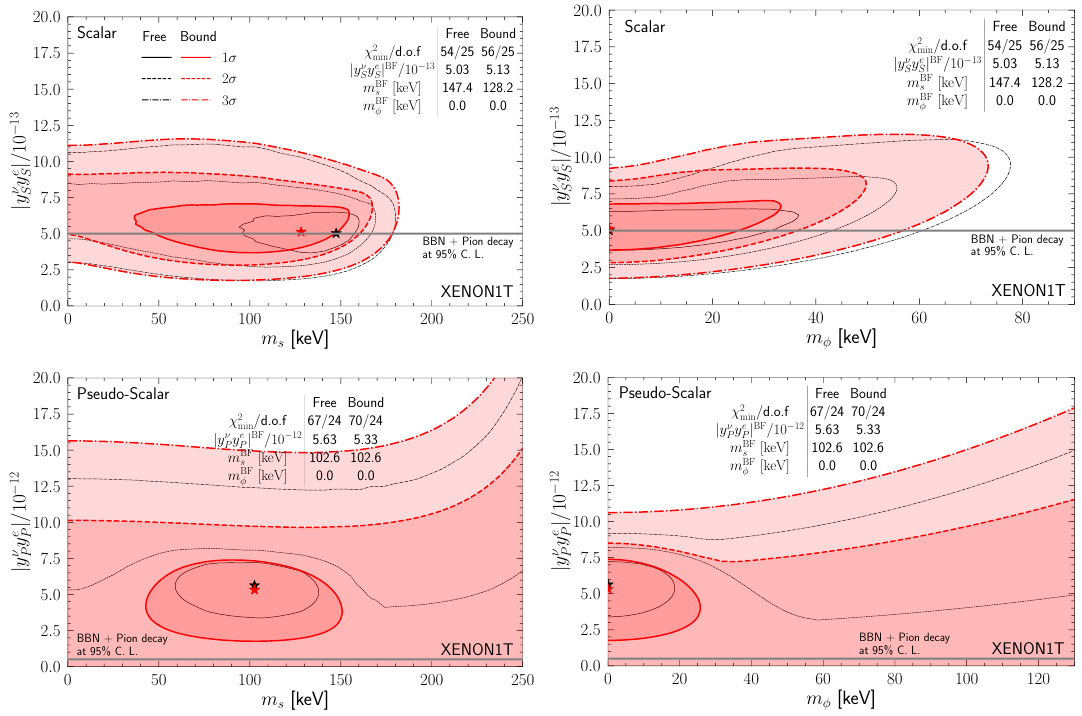
Figure 7 . The XENON1T constraints for scalar (up), pseudo-scalar (bottom) interaction couplings | y ν y e | versus m s (left) and m φ (right) at 1 σ , 2 σ , and 3 σ C.L. The black curves are for the S,P S,P free electron approximation and red ones for the bound electron scenario whose best-fit points are indicated with black (free) and red (bound) stars, respectively. The mediator (sterile neutrino) mass m φ ( m s ) is marginalized over 0 keV < m φ < 175 keV ( 0 keV < m s < 250